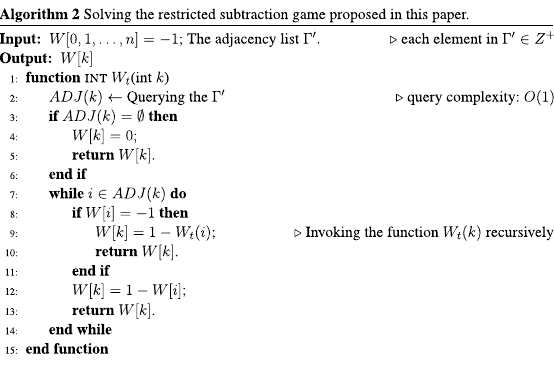
Algorithm 2. Solving the restricted subtraction game proposed